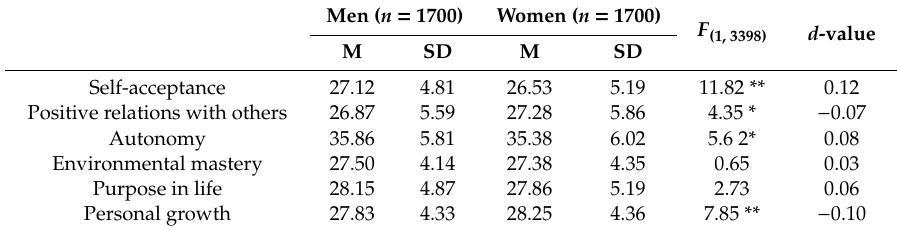
Table 2. Means ( M ), standard deviations ( SD ) and comparisons for men and women for the well-being scales.